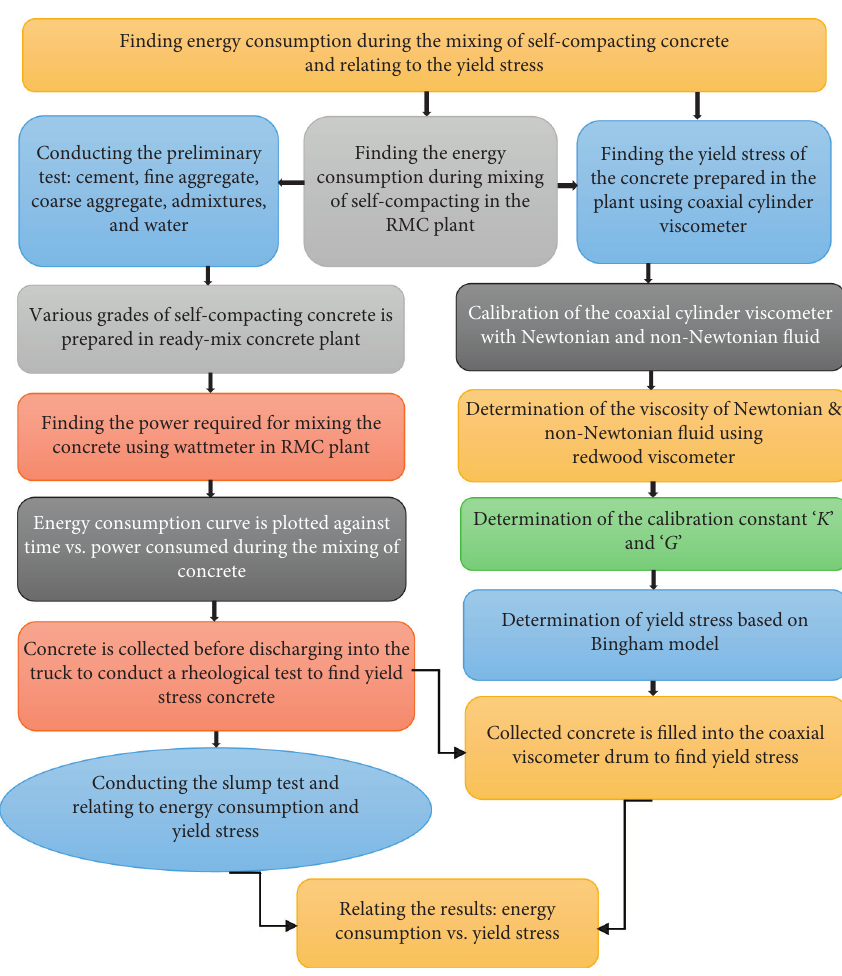
Figure 4: Methodology to determine energy consumption during mixing of concrete and its yield stress. Table 1: Viscosity of the Newtonian fluid. S.